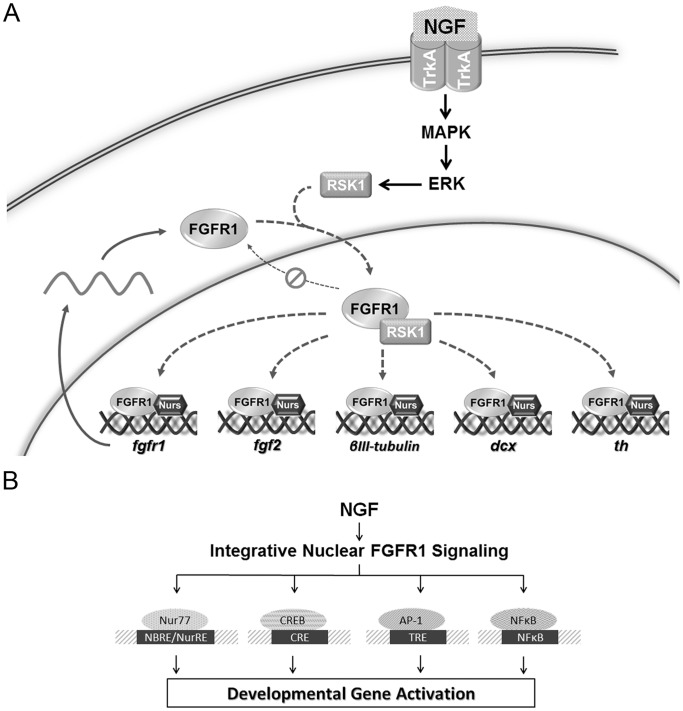
INFS as a transducer of NGF signals to ssTF.(A). Cross-talk between NGF signaling and INFS. NGF stimulates the MAP/ERK pathway resulting in increased RSK1 activity [11], [13], which is known to promote the release of newly synthesized FGFR1 from pre-Golgi membranes into the cytosol and accumulation in the cell nucleus [33]. RSK1 binding to FGFR1 in the nucleus decreases FGFR1 mobility promoting the FGFR1 nuclear retention accumulation [32]. Increased nuclear FGFR1 correlates with FGFR1 interaction with Nur proteins [24], [25] and Nurs also decrease nuclear FGFR1 movement [25]. The FGFR1/Nur complexes generated by NGF stimulation activate Nur-responsive sites on diverse genes. In addition, upregulation of fgf-2 mRNA by NGF (Fig. 4A) could also contribute to FGFR1 nuclear trafficking since the nuclear accumulation and retention of FGFR1 is facilitated by its ligand FGF-2 [32], [36] (not shown on diagram). (B) The end-point ssTF of NGF stimulation, in addition to Nurs, include CREB, AP1, and NFKB [71]. The same end-point factors were shown to be activated by nuclear FGFR1 through the CBP/RSK1-dependent feed forward mechanism [23]. This common INFS step may enable coordinated programing of diverse genes necessary for NGF-induced neuronal differentiation.